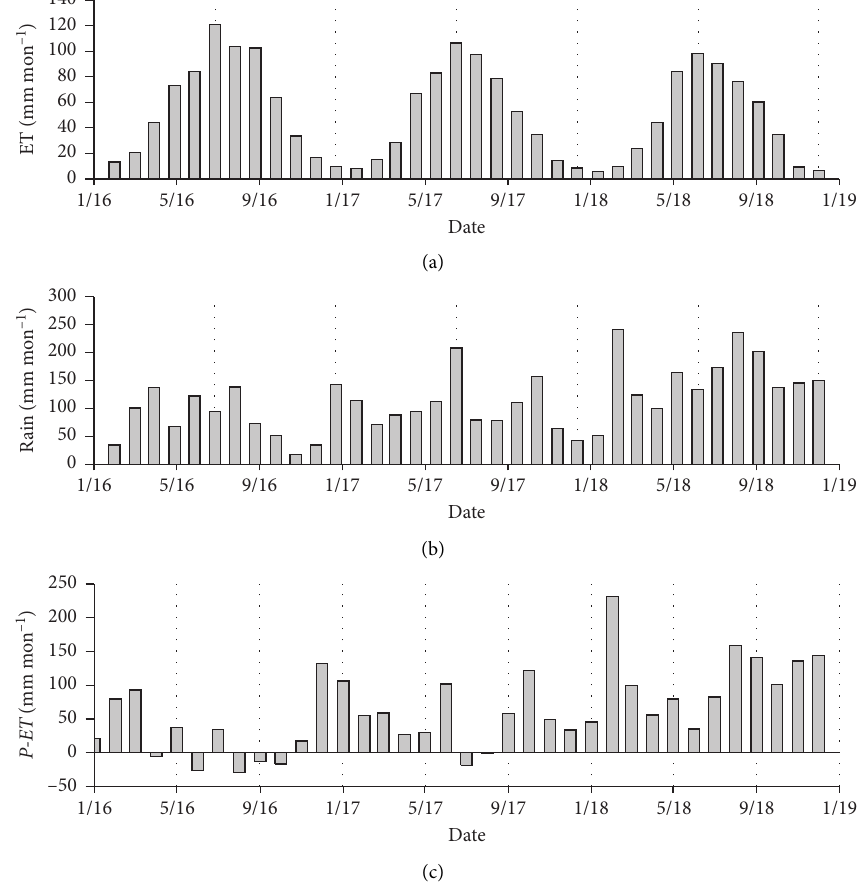
Figure 6: Monthly ETanomaly (defined here as P-ET) during 2016–2018, where P is precipitation. The monthly P -ETvariation is controlled by precipitation exhibiting positive ( P > ET) and deficit ( P < ET). Precipitation data were obtained from the nearby ( < 2 miles) Kentucky Mesonet weather